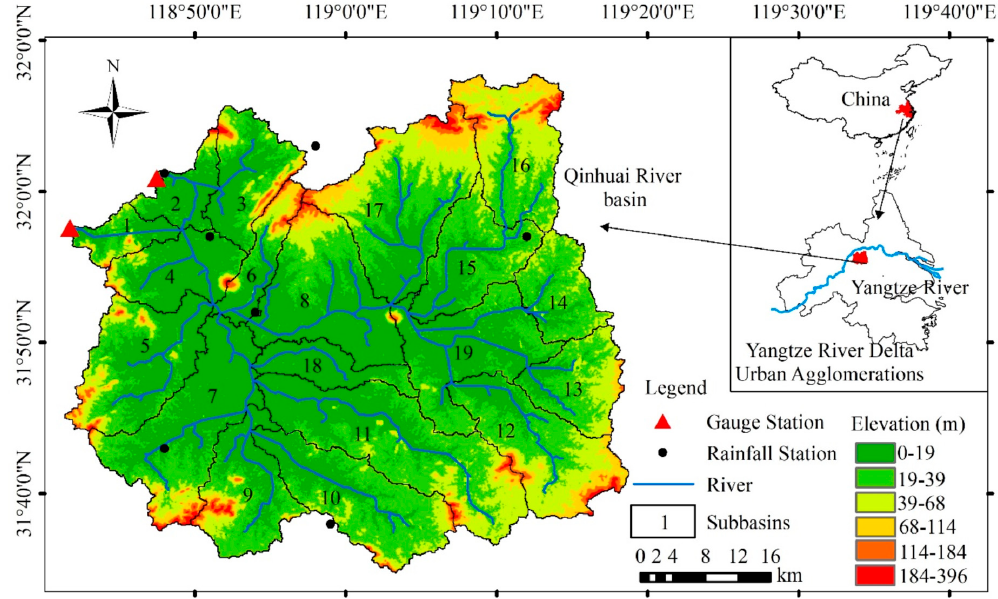
Figure 1. Location of Qinhuai River basin and distribution of sub-basins.